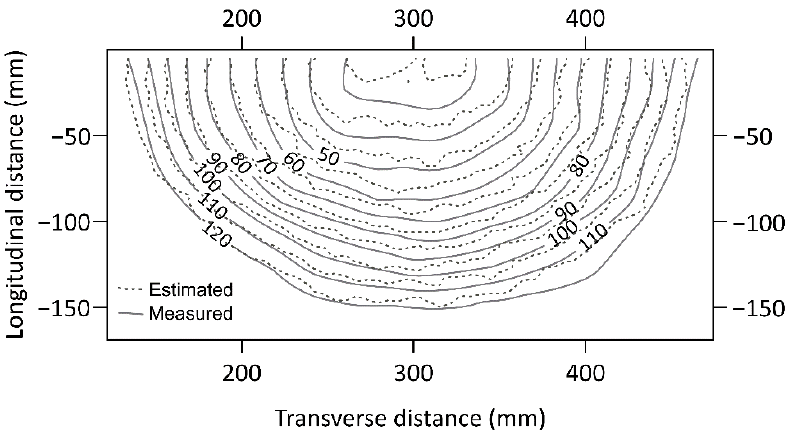
Figure 10. Contour plots for Test no. 3 by SfM estimation and Manual measurement in model scale, Case study III.